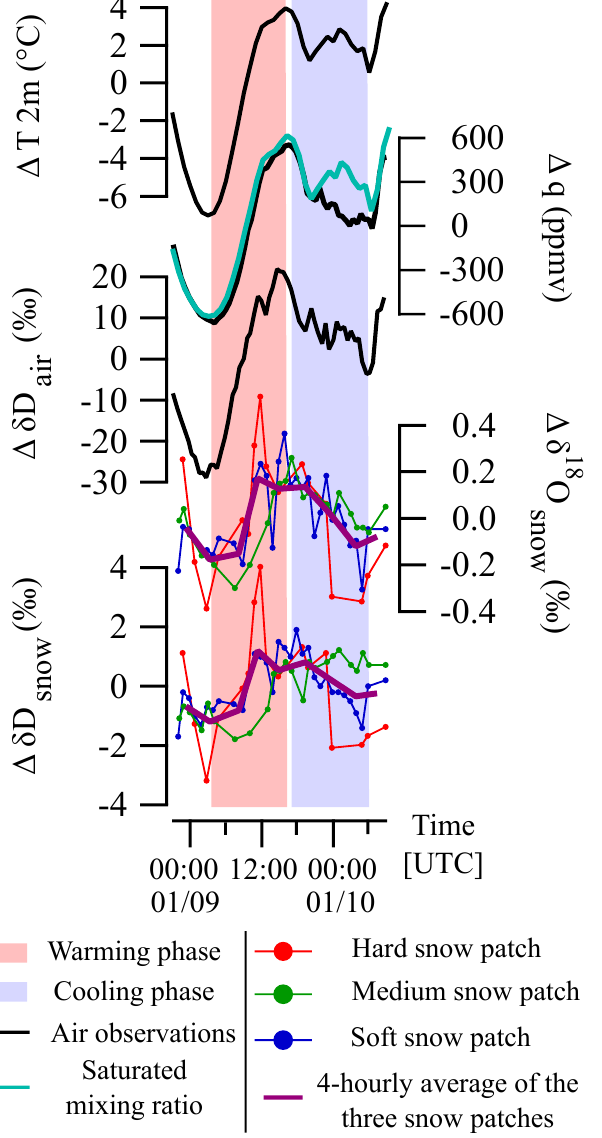
Figure 4. Observations performed during the Snow Surface Diurnal Cycle (SSDC) experiment from the 9 to 10 January 2014. The three different snow patches are labeled “hard”, “medium” and “soft” ac- cording to their texture. Each hourly data point is the average of the measurements made on 5 snow surface samples per patch.